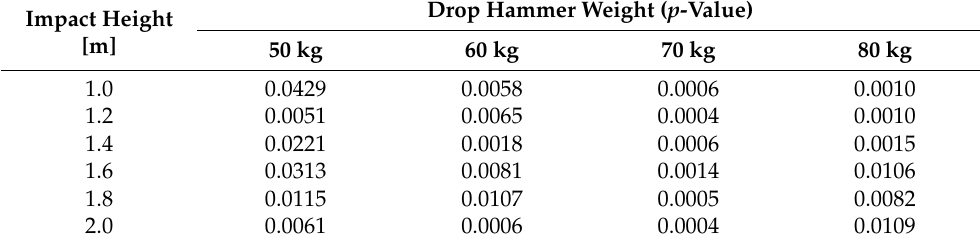
Table 2. Test results—paired t -test ( α =